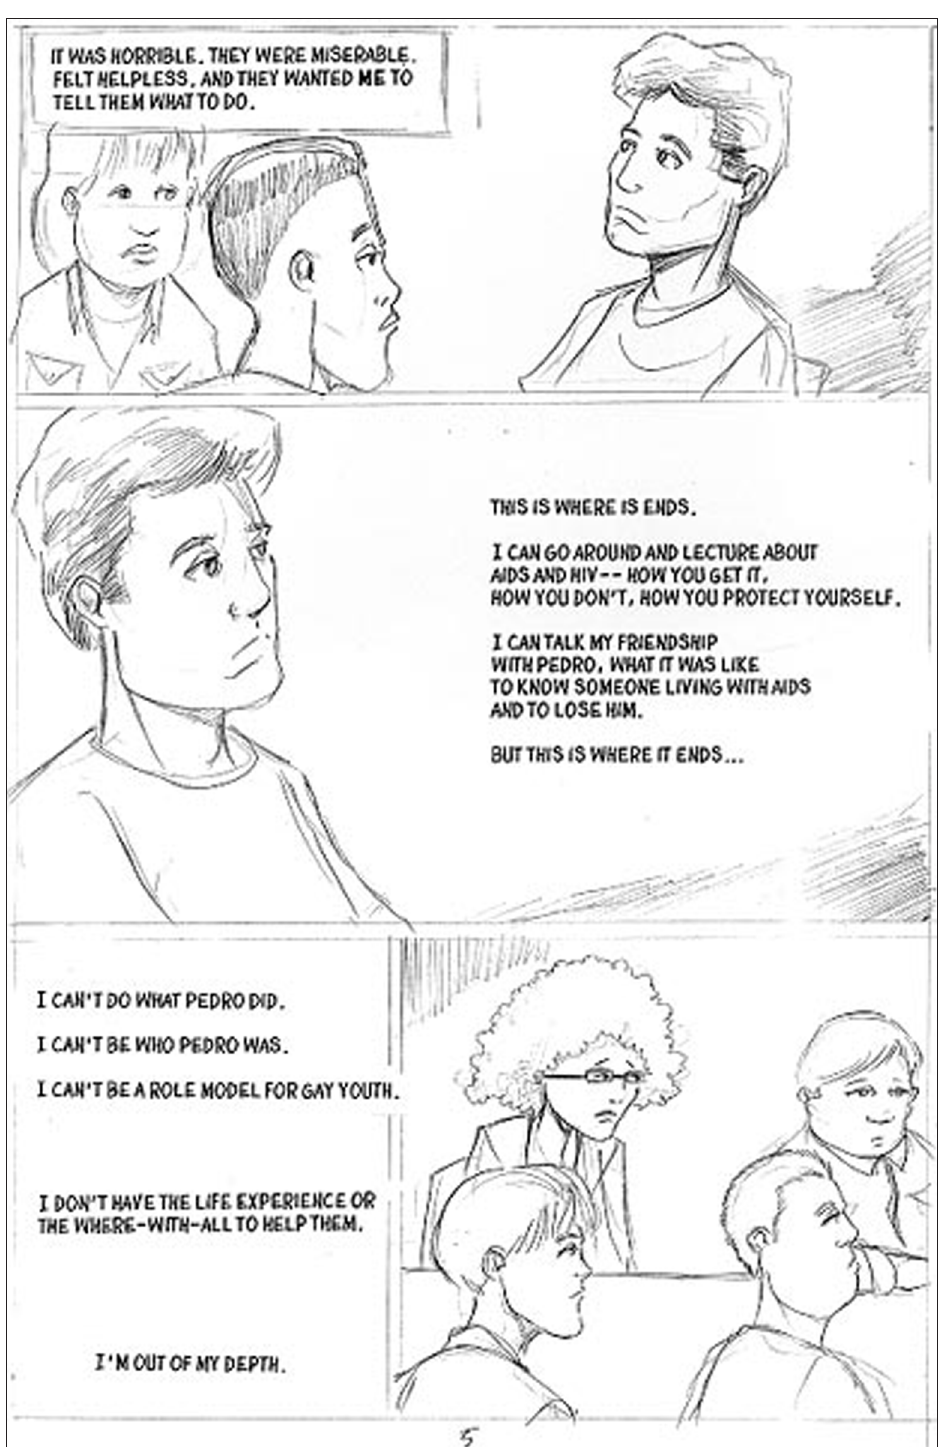
Figure 1: Judd feels "out of his depth" in Pedro's place. This sequence by Judd Winick originally appeared on a former Henry Holt mini-site to support the release of the first edition of Pedro and Me. Judd Winick, Henry Holt defunct Pedro and Me site, still available at https://web.archive.org/web/20071018075021/http://www.captionbox.net/ pedro/cutpages2.html. © 2000 Judd